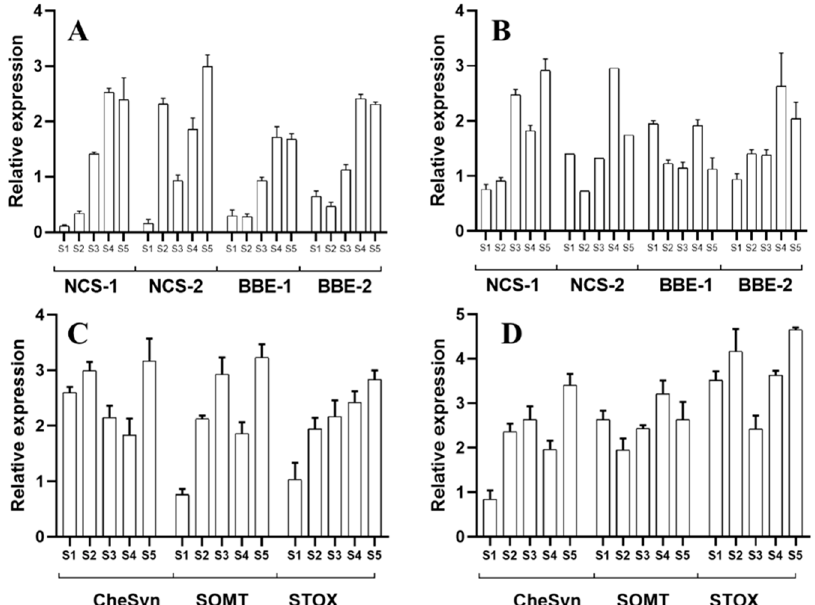
Figure 5. Relative abundance of the transcript involved in alkaloid biosynthesis in A. mexicana hypocotyls. The developmental stages correspond to S1 to S5, as shown in Figure 2B. ( A , B ) are the relative transcript abundance for NCS and BBE in cotyledons and radicles, respectively. ( C , D ) are the relative transcript abundance for SOMT , STOX and CYP71914 ( ChESYN ). The average of triplicates with the standard deviation is given. ACTIN was used as the reference gene.